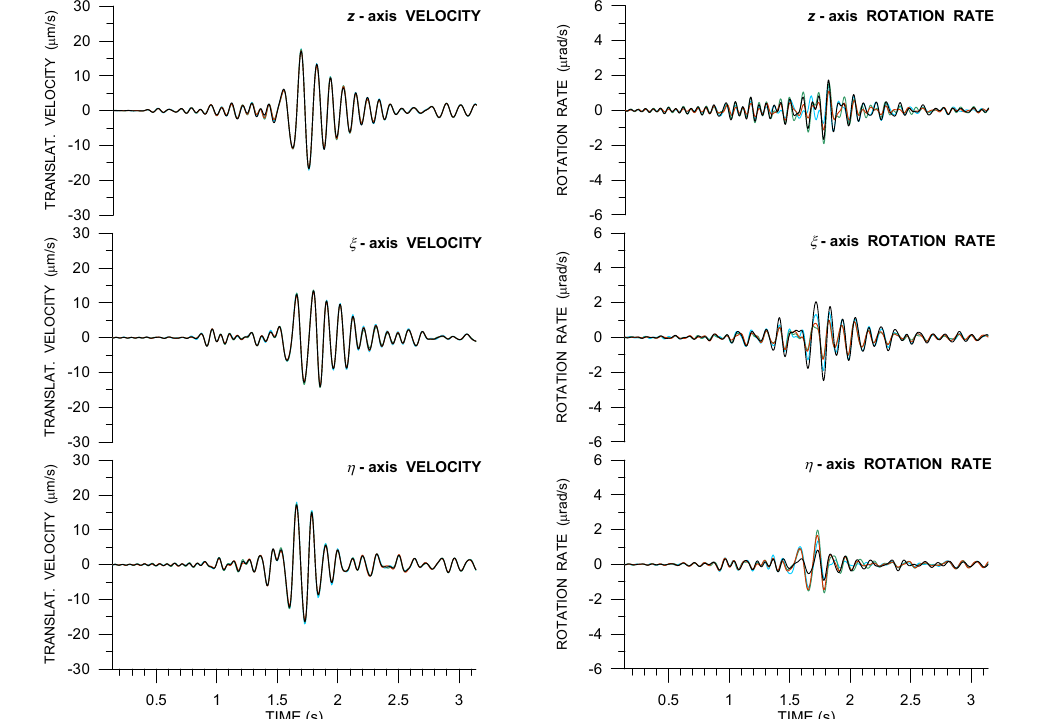
Figure 8. A small-size explosion (Expl3 in Table A1) at a distance of 452 m from R10 as recorded by four 6C Rotaphone- CY instruments (R8—red, R10—black, R11—light blue, and R13—green) in the active phase of the GOF experiment. The horizontal components are rotated into radial and transverse directions, according to the geometrical azimuth of 294.0 ◦ .